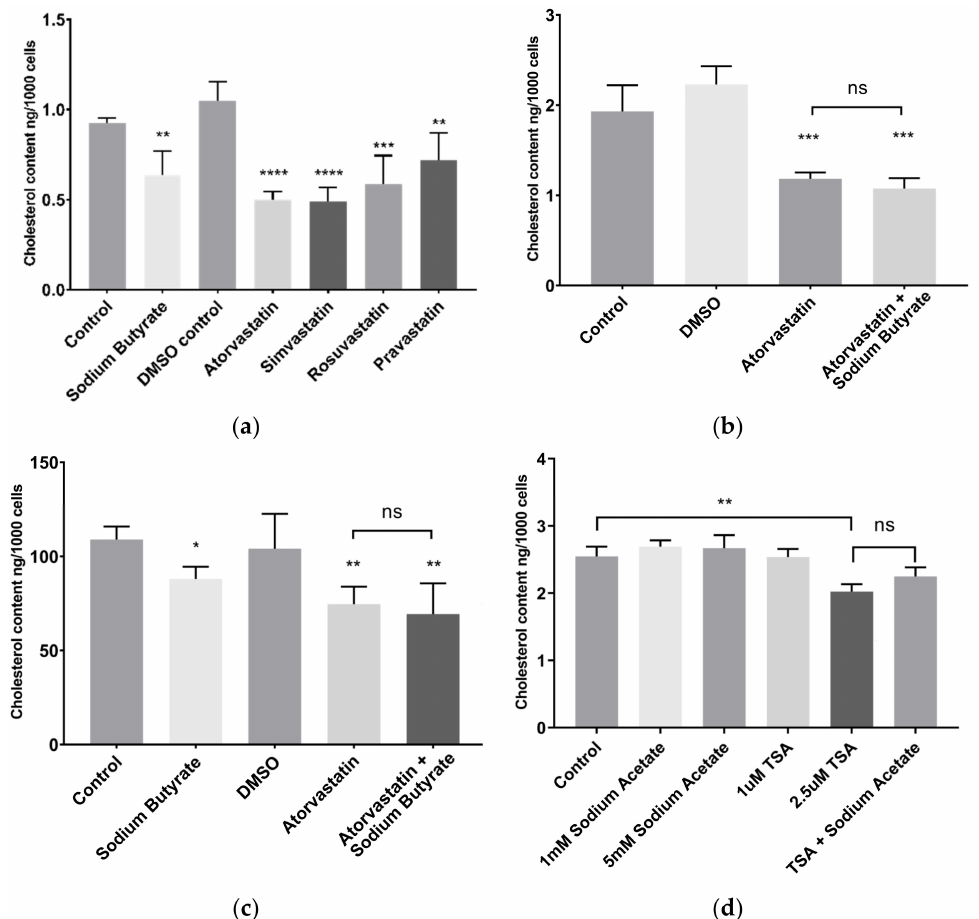
Figure 2. The cell cholesterol content of HepG2 cells is decreased by statins, and by the HDAC in- hibitors, butyrate and TSA. The treatments were for 24 h and using: ( a ) 10 µ M statins or 5 mM sodium butyrate in media supplemented with lipoprotein deficient serum (LPDS); ( b ) 10 µ M atorvastatin with or without 5 mM sodium butyrate in media containing LPDS; ( c ) 10 µ M atorvastatin, 5 mM sodium butyrate or in combination, in media supplemented with high lipoprotein serum (HLPS); ( d ) sodium acetate (SA) or trichostatin A (TSA) in media containing LPDS. The experimental control for butyrate treatment comprised of cells treated with media only (Control) and for statins, treatment with media containing dimethyl sulfoxide (DMSO). Results represent the mean from at least three independent experiments, with error bars representing SEMs. * p < 0.05, ** p < 0.01, *** p < 0.001, **** p < 0.0001, ns not